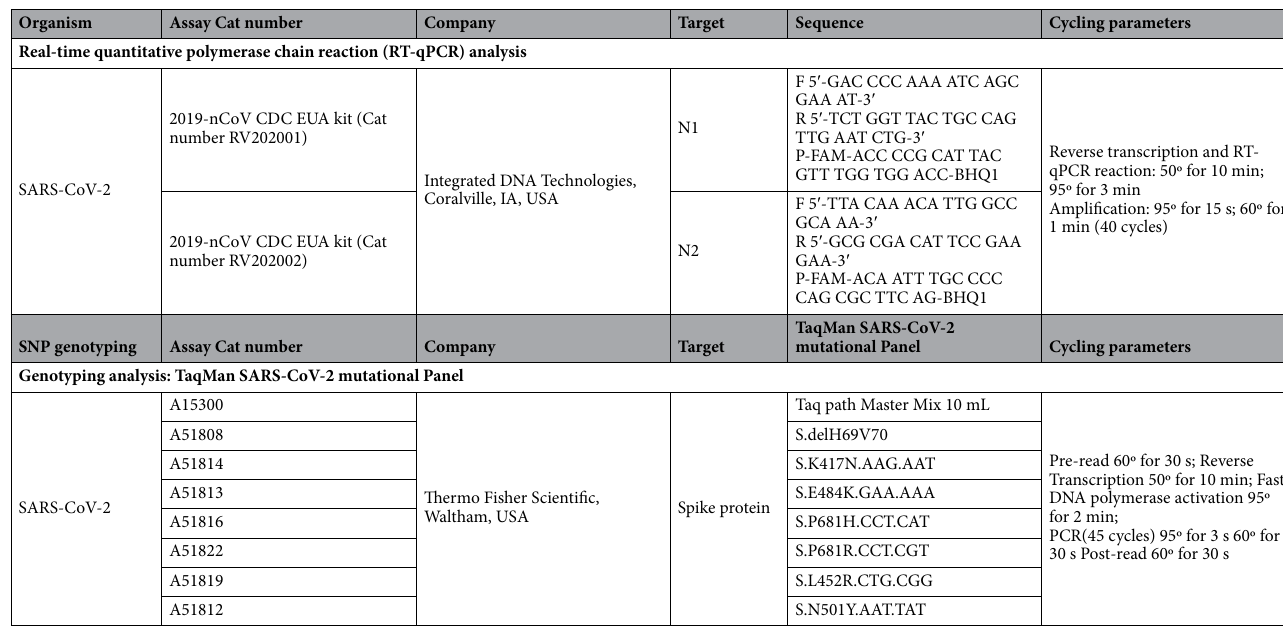
Table 2. Thermal cycling conditions, primers/probes for RT-qPCR and SNP genotyping used in the